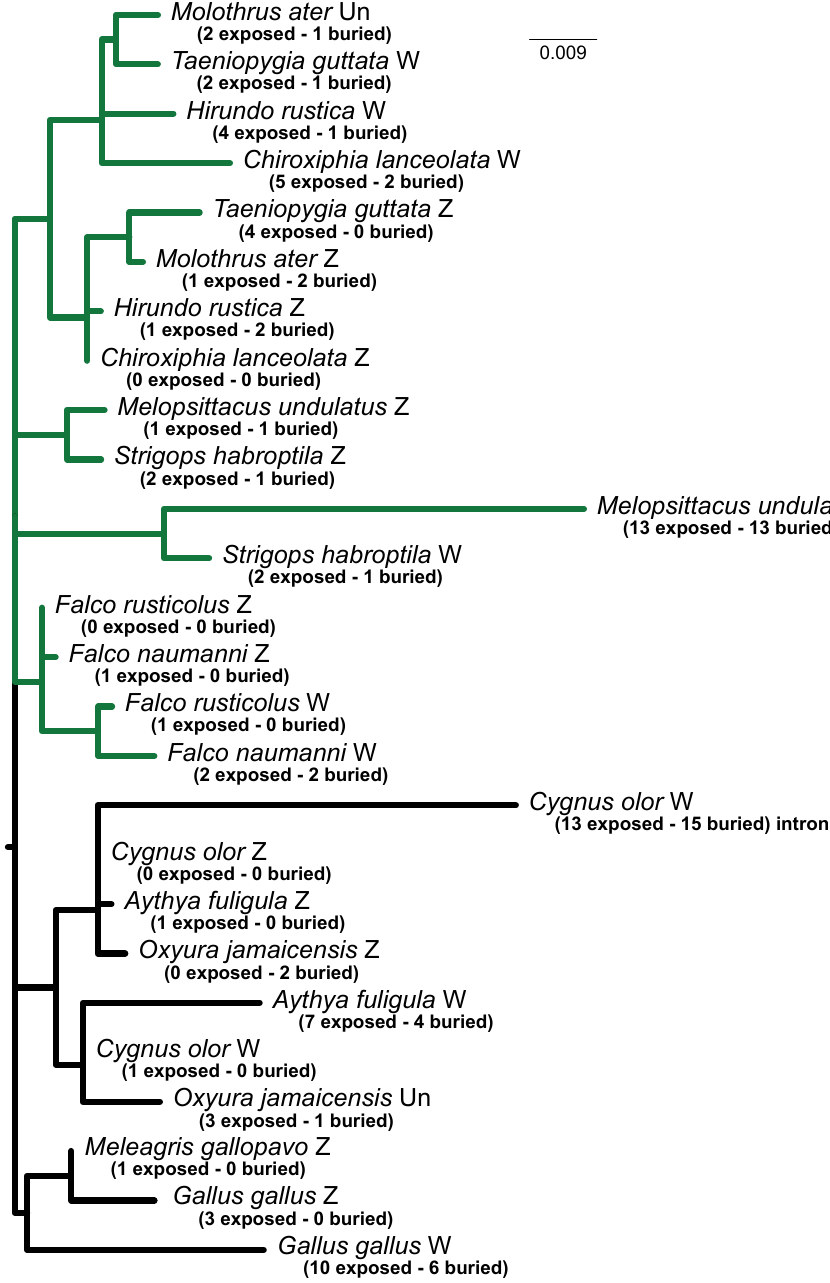
Figure 5. Maximum likelihood branch length estimates of ATP5F1A protein sequences using a topology that maximizes congruence with the best estimate of the species tree [67] (using the IOC world bird list v. 11.2 [49]) and places the recombination blocks in positions compatible with the intronic tree. These branch lengths were estimated using the MamXB model and numbers of exposed and buried substitutions on each terminal branch are presented to the right of each taxon. Colors identify major clades, and are those used in Braun and Kimball [66]. The maximum likelihood topology with ultrafast bootstrap support is presented in Supplementary Figure